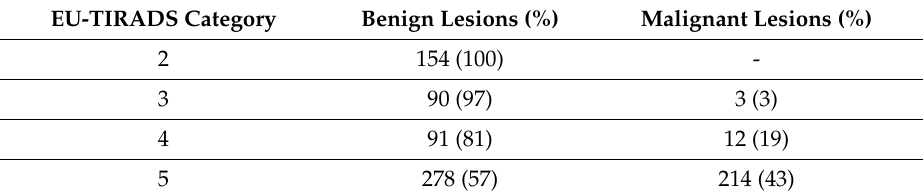
Distribution of the thyroid lesions in selected EU-TIRADS categories according to histopathological